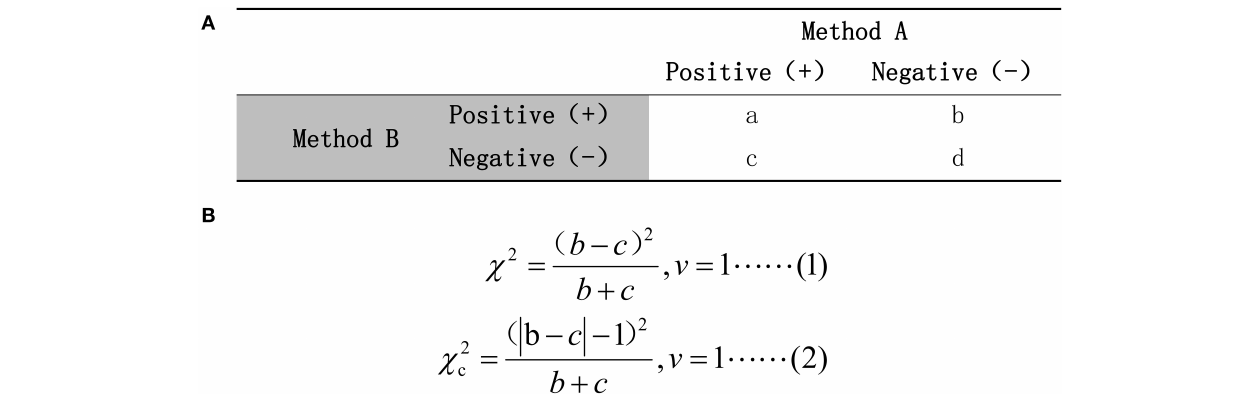
Frontiers in Oncology |